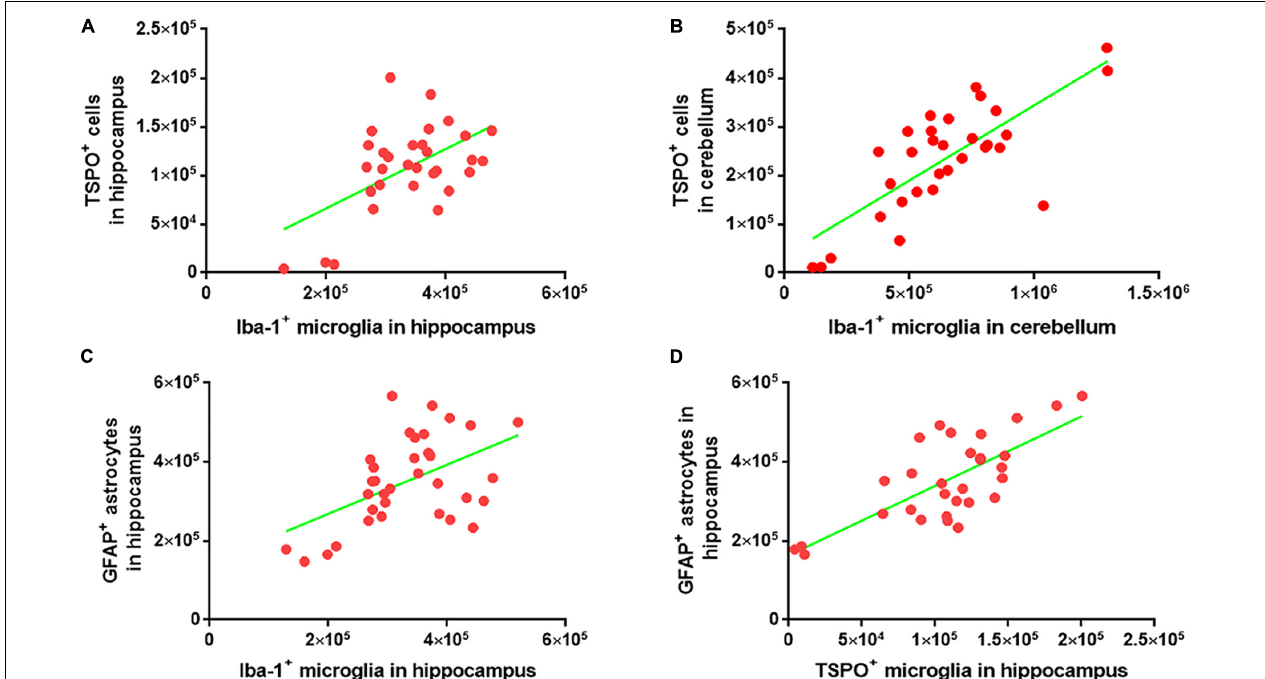
FIGURE 7 | Correlation analysis among the Iba-1 + microglia, TSPO + microglia/macrophages, and GFAP + astrocytes. (A) Graphical representation of the correlation between Iba-1 + microglia and TSPO + cells in hippocampus. The data were analyzed using linear regression and correlation. ∗∗ p < 0.001, R2 = 0.29 ( n = 31) (B) Graphical representation of the correlation between Iba-1 + microglia and TSPO + cells in the cerebellum. The data were analyzed using linear regression and correlation. ∗∗∗∗ p < 0.0001, R2 = 0.58 ( n = 31) (C) Graphical representation of the correlation between Iba-1 + microglia and GFAP + astrocytes in hippocampus. The data were analyzed using linear regression and correlation. ∗∗ p < 0.002, R2 = 0.25 ( n = 34) (D) Graphical representation of the correlation between TSPO + microglia/macrophages and GFAP + astrocytes in hippocampus. The data were analyzed using linear regression and correlation. ∗∗∗∗ p < 0.0001, R2 = 0.54 ( n = 30).